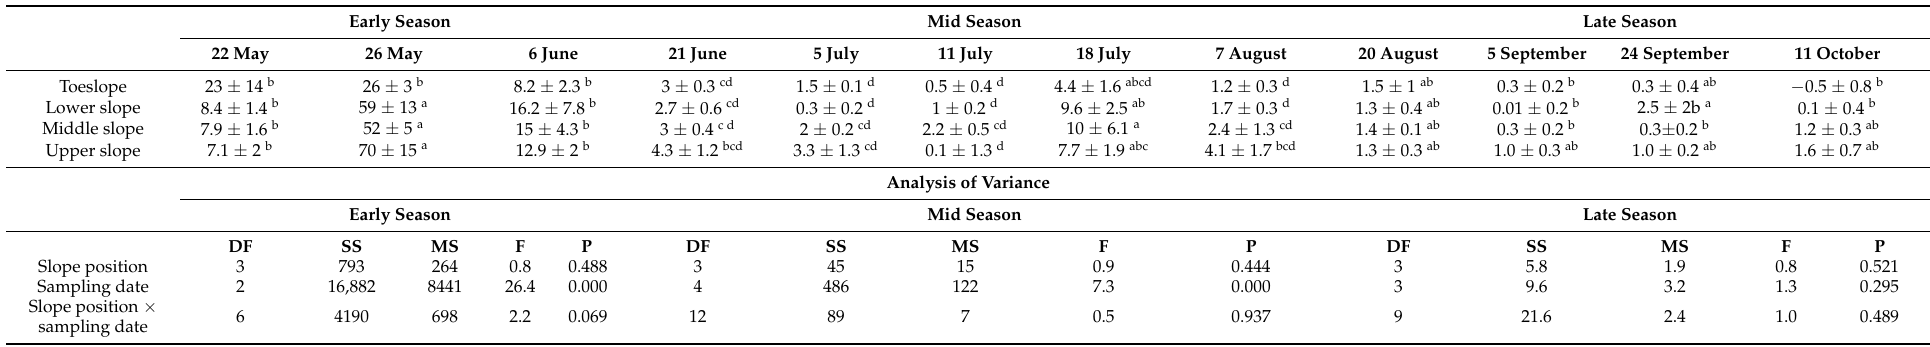
Table 3. Soil N 2 O emissions (g ha − 1 d − 1 ) from different slope positions at different sampling dates during early, mid and late growing season (2019) from Research North farm. Means sharing different letters in different growing seasons are significantly different from each other (LSD, p < 0.05).